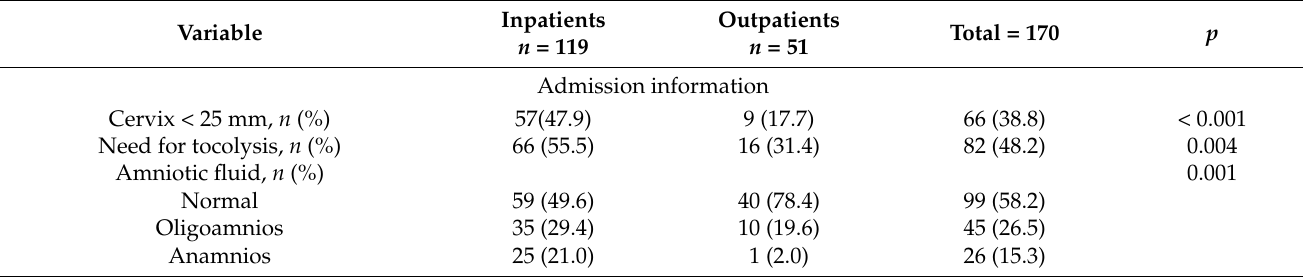
Table 6. Inpatient and outpatient